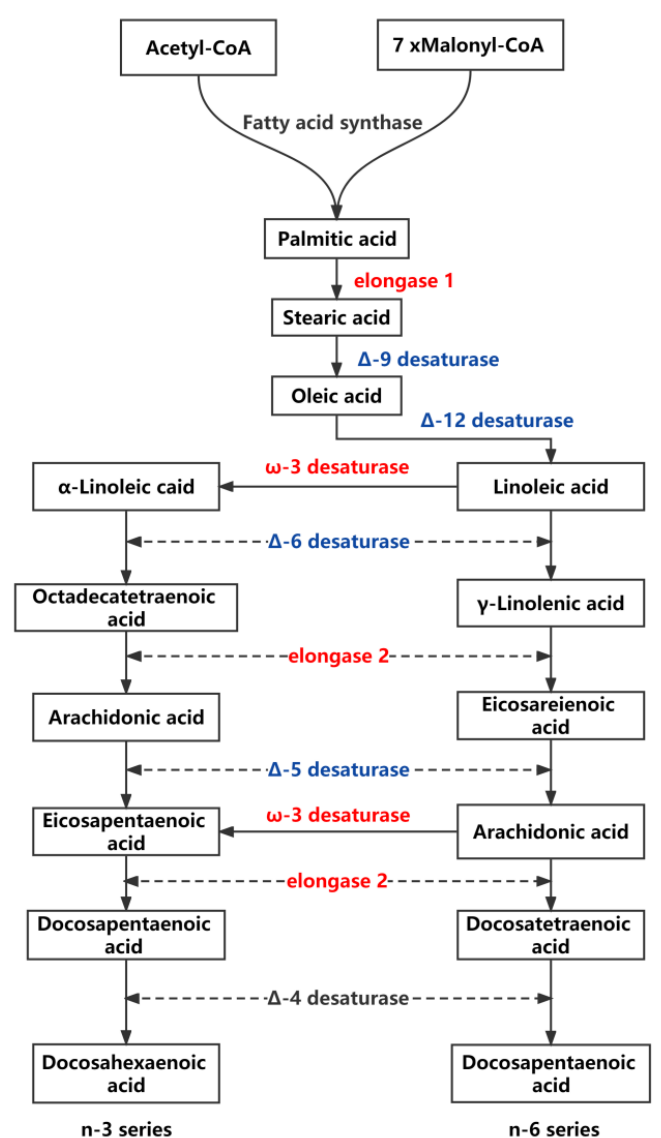
Figure 11. Metabolic pathway of polyunsaturated fatty acids (PUFAs) in Mortierella alpina under cold stress. Enzymes showing up-regulation and down-regulation are indicated in red and blue, respectively.